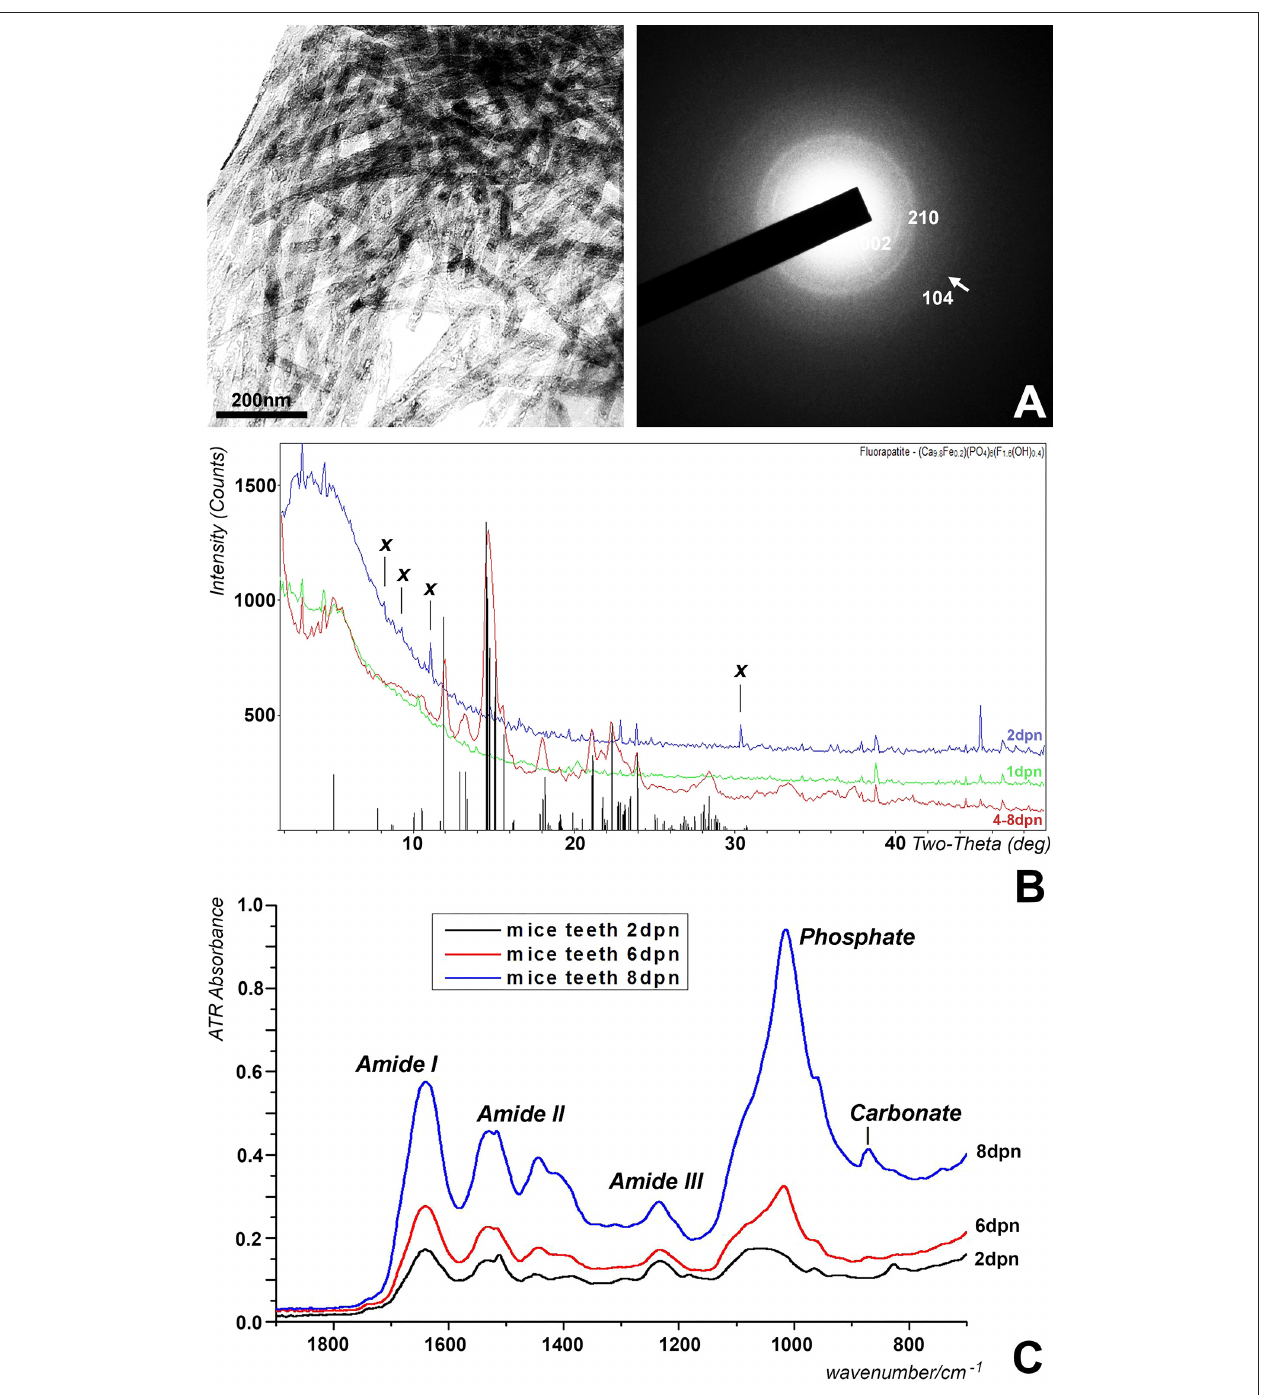
FIGURE 3 | Analysis of the postnatal mouse molar enamel mineral layer. (A) Transmission electron microscopy of 4 days postnatal mouse molar enamel matrix revealed bundles of thick apatite crystals with diffraction rings in the 002 and 210 planes, and a faint diffraction ring in the 104 plane, indicative of hydroxyapatite. (B) X-ray powder diffraction analysis of enamel matrix preparations from the distal slopes of 1 day postnatal (1 dpn), 2days postnatal (2 dpn), 4, 6, and 8 days postnatal (4–8 dpn) mouse mandibular molars. The vertical bars at the base of the figure illustrate the partially fluoride substituted hydroxyapatite powder diffraction pattern with the height of the bars representing relative peak intensities. Unique unmatched peaks in the spectrum of 2 days postnatal samples were marked by an X. Only the 4–8 dpn samples matched hydroxyapatite powder diffraction standards. (C) Fourier-transform infrared spectra of developing enamel matrix preparations from the distal slopes of 2 days postnatal (2 dpn), 6 days postnatal (6 dpn), and 8 days postnatal (8 dpn) mouse mandibular molars. Peaks corresponding to vibrations for phosphate, carbonate, proteoglycan, and amide I–III are labeled individually.